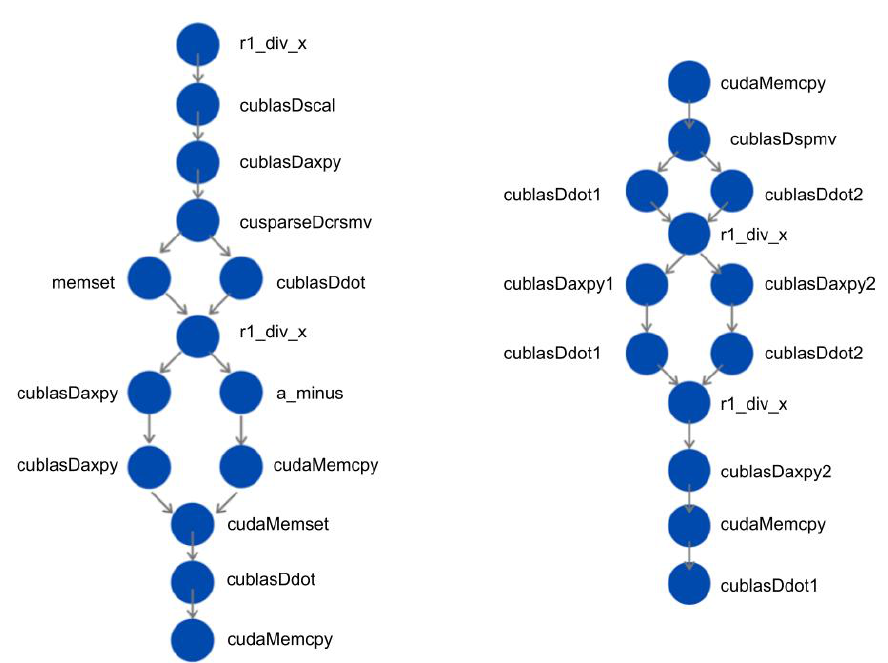
Figure 1. Graph configuration for the NVIDIA CG reference code ( left ) and optimized ap- proach ( right